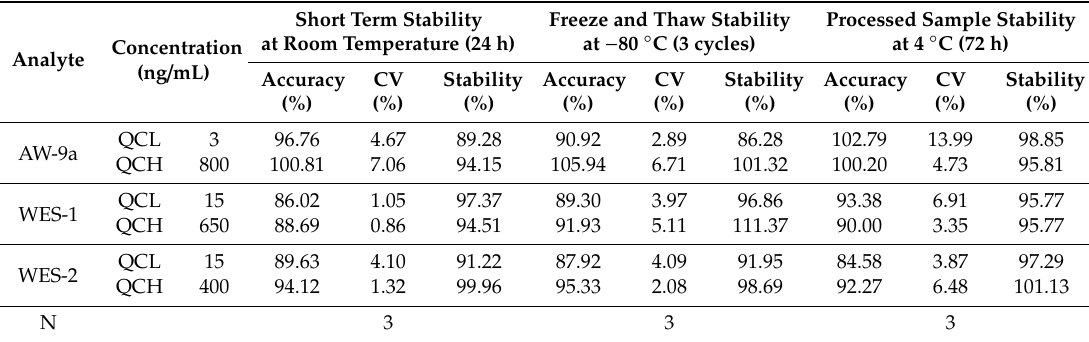
Table 4. Stability results for AW-9a, WES-1, and WES-2 in human plasma at di ff erent conditions.